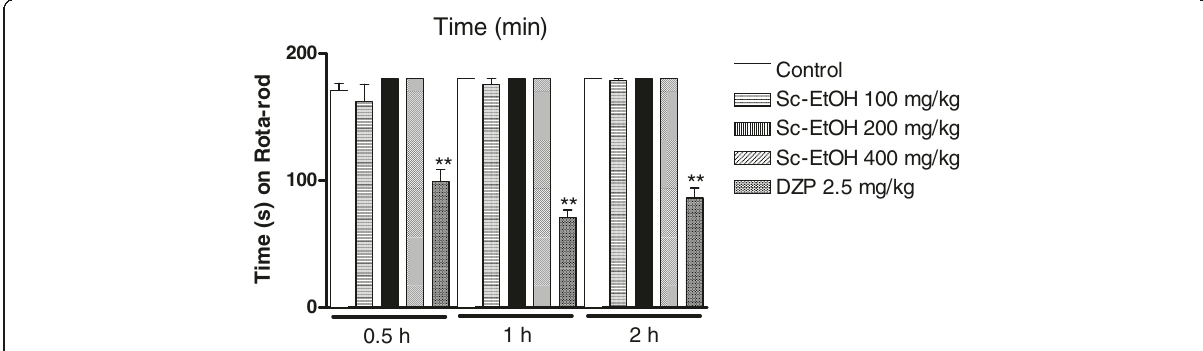
Figure 6 Effect of ethanolic extract of Selaginella convoluta (Sc-EtOH) and diazepam (DZP) on rota-rod test. Values are mean ± S.E.M.; **p < 0.01, significantly different from control; ANOVA followed Dunnett ’ s test (n = 6, per